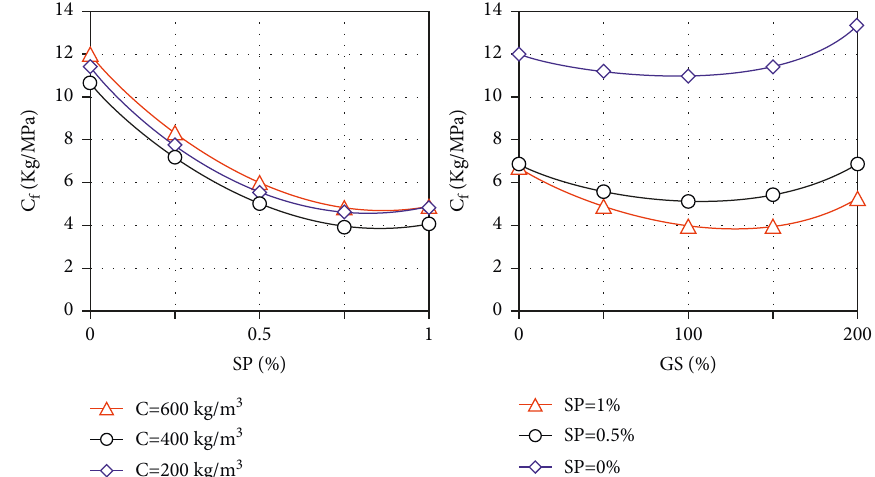
Figure 7: The influence of investigated factors on the specific consumption of cement per unit strength (the values of the third factor are at the average level (Table